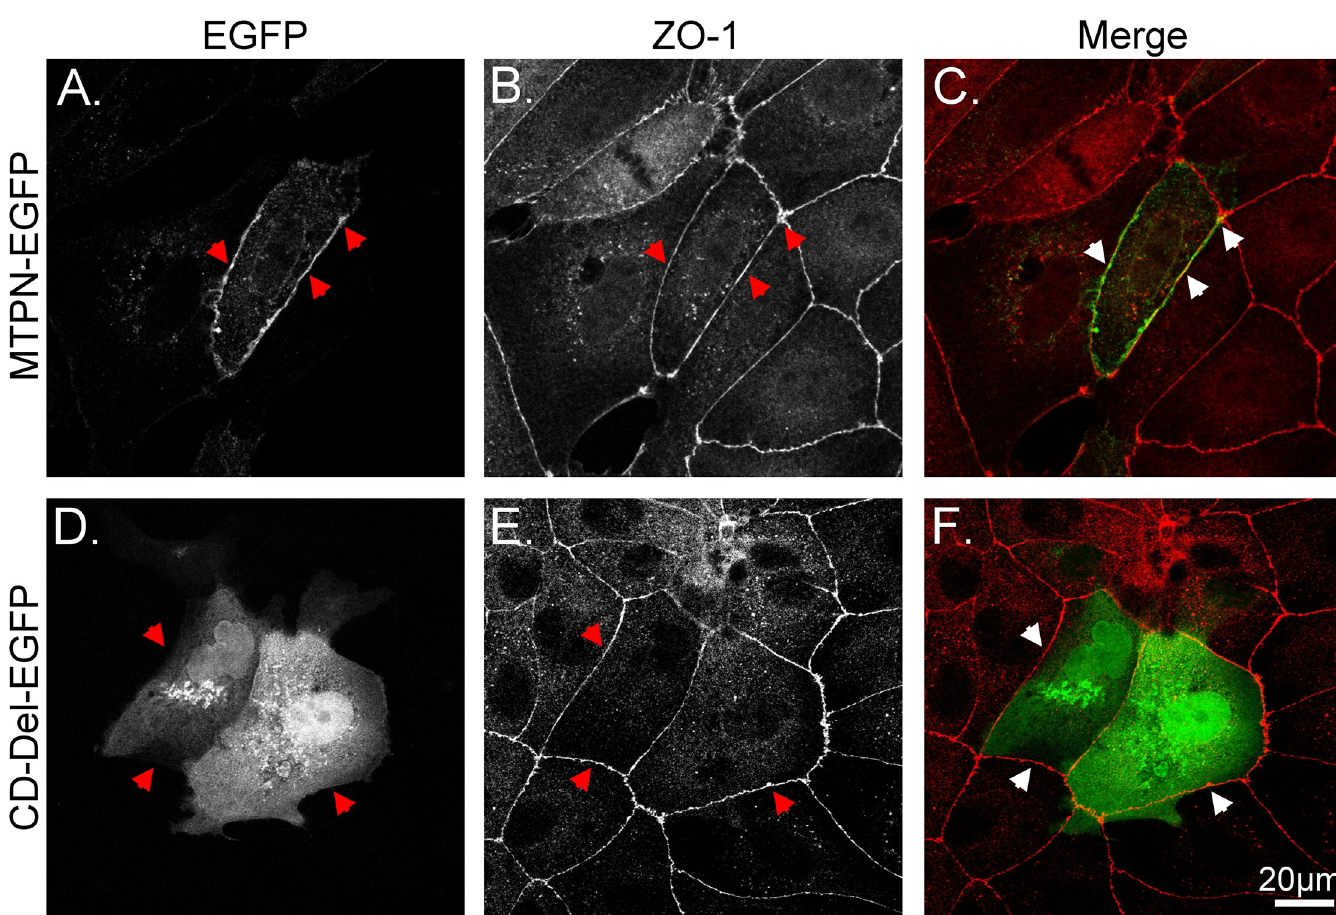
Fig 3. Exogenous expression and subcellular localization of MTPN-EGFP and CD-Del-EGFP in MDCK cells. Both wild-type (MTPN-EGFP) and cytoplasmic domain deleted (CD-Del-EGFP) matriptase-EGFP constructs were transiently expressed in MDCK canine distal renal tubular epithelial cells. The subcellular localization of both MTPN-EGFP (A and C) and CD-Del-EGFP (D and F) were compared with the tight junction marker ZO-1, which was analyzed by indirect immunofluorescent staining using ZO-1 antibody, followed by Alexa 594-labeled anti-mouse IgG (B and E). The staining is presented as black and white images (A, B, D, and E) and merged false-color images ( C and F ). The arrowheads indicate the cell periphery. Scale bar: 20 μ